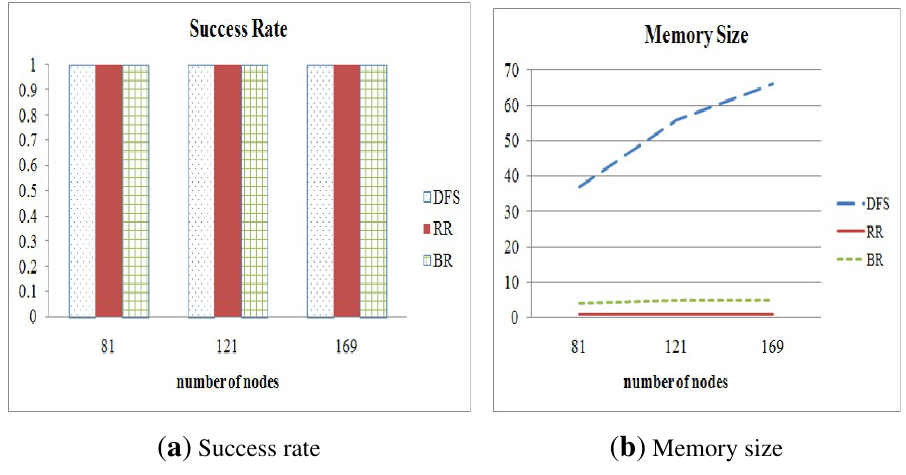
Figure 12. Success rate and memory size in relation to various node